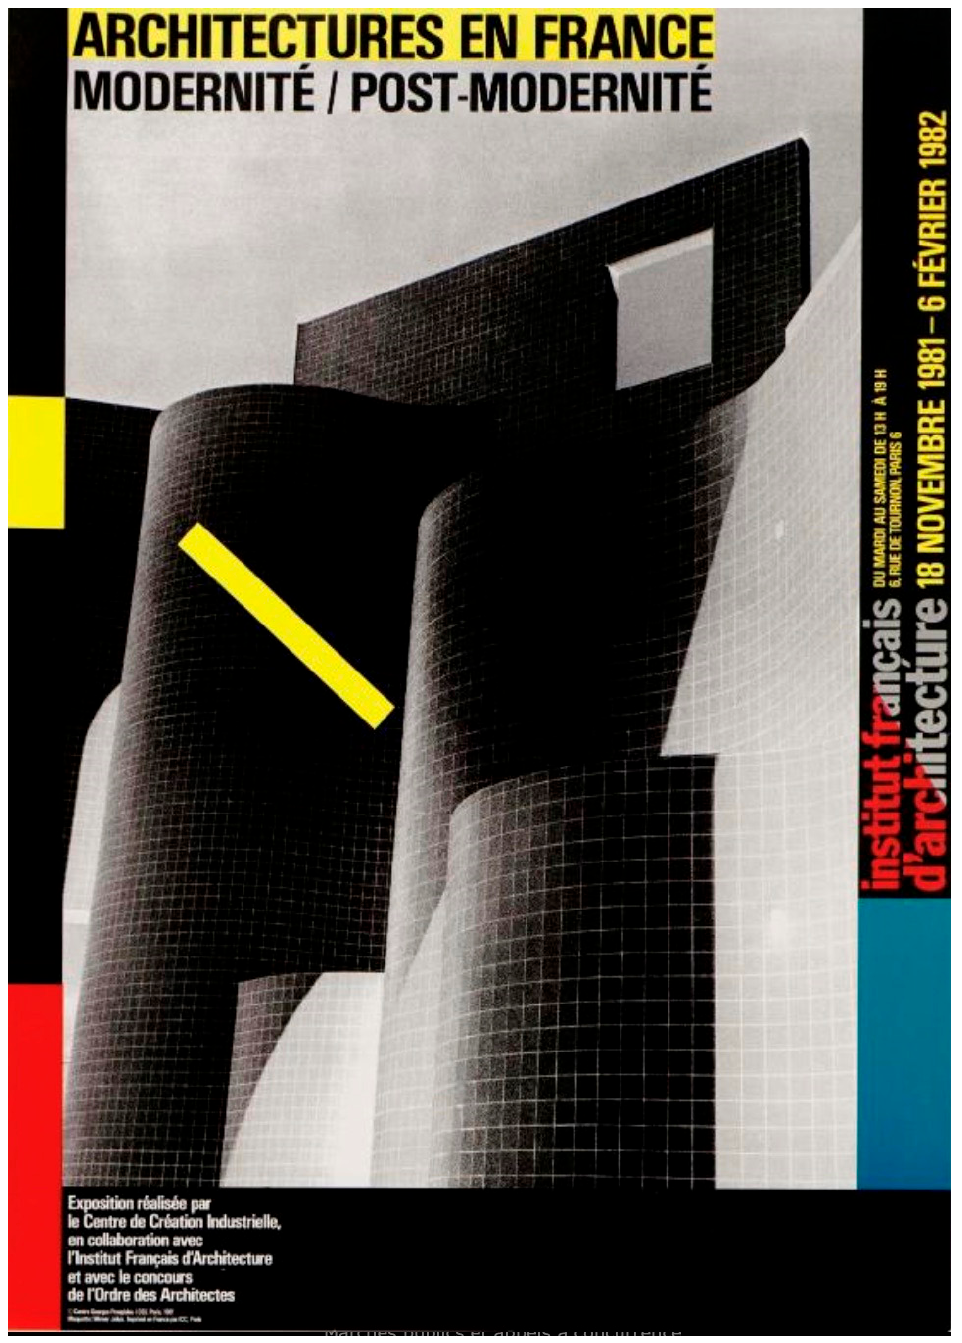
Figure 8. Poster of the exhibition Architectures en France: Modernité/post-modernité , curated by Chantal Béret and held at the Institut Français d’Architecture from 18 November 1981 through 6 February 1982. © Centre Pompidou, 1981. Graphic conception by Werner Jerker.